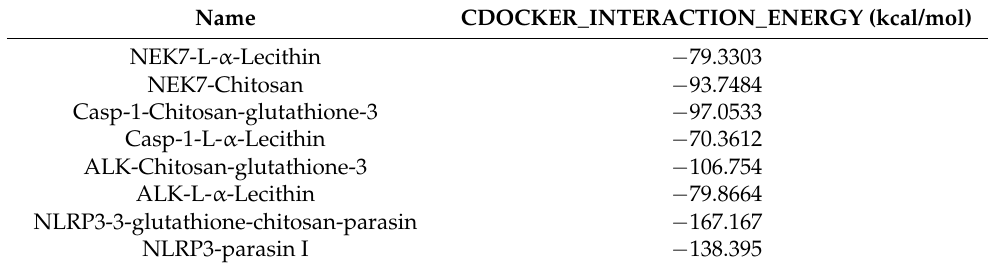
Table 1. The interaction force and energy between NLRP3 components with chitosan, lecithin, or parasin